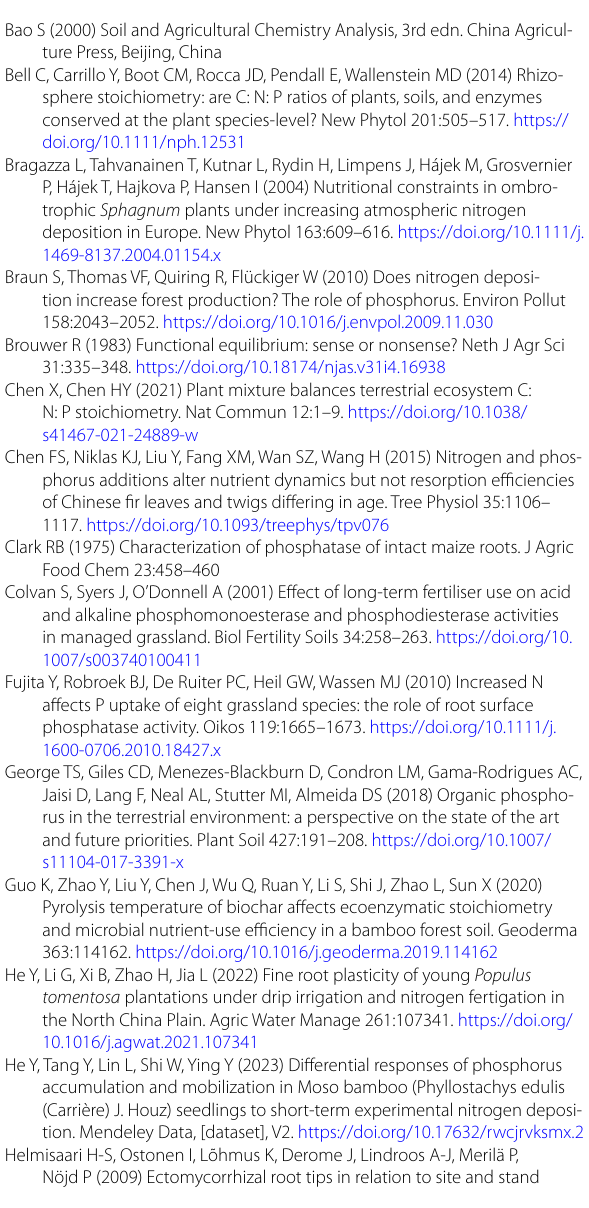
Table 6 Diameter and height of P. edulis seedlings at the final harvest (May 7, 2019) in different treatments Indices N − P 1 P 2 P 3 P 1 P 2 P 3 P 1 P 2 P 3 Diameter 1.73 0.05 e 2.43 0.04 d 2.58 ± ± (cm) Height 16.6 1.85 d 26.4 2.47 ± ± (cm)